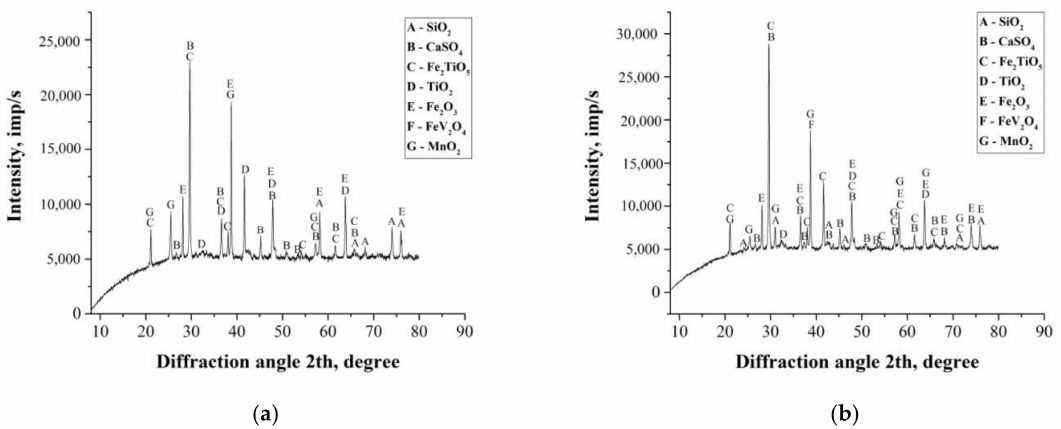
Figure 3. Diffractograms acquired from samples of roasted sludge with 1% CaCO 3 ( a ) and 2% MgO ( b )